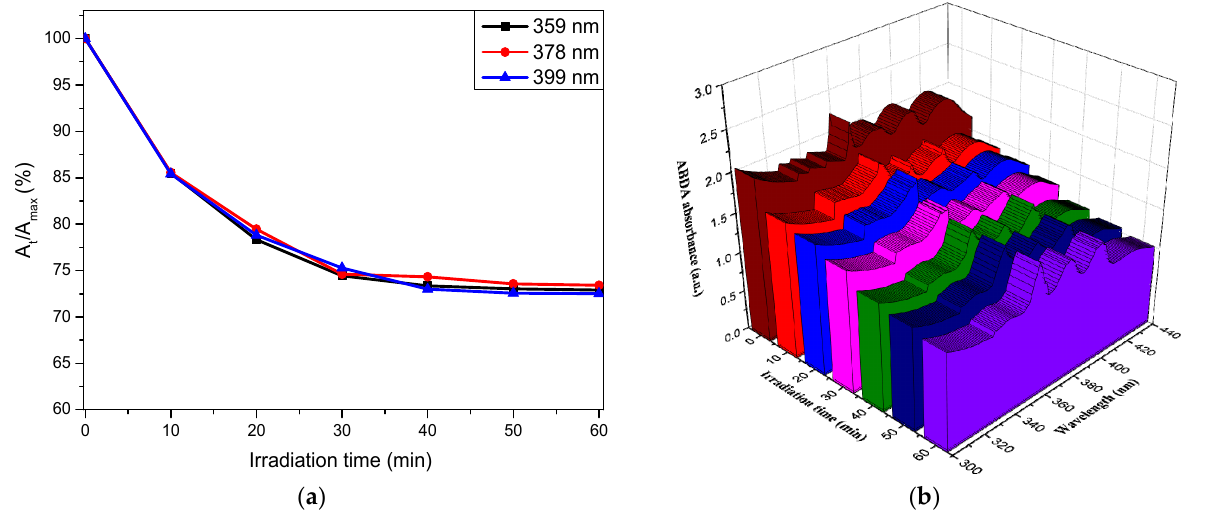
Figure 8. Under NIR exposure, the UV-vis absorbance change of Ho 3+ -doped UCNP@mSiO 2 / MC 540 donor-acceptor system ( a ) as a function of irradiation time and ( b ) as a function of irradiation time and absorption wavelength. Table 2. ROS generation for oleate-capped UCNPs, ligand-free UCNPs, and mSiO 2 -coated UCNPs with their corresponding photosensitizers.